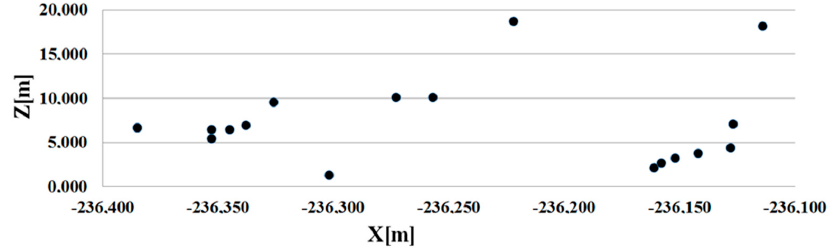
Figure 2. Illustration of measurement strip.